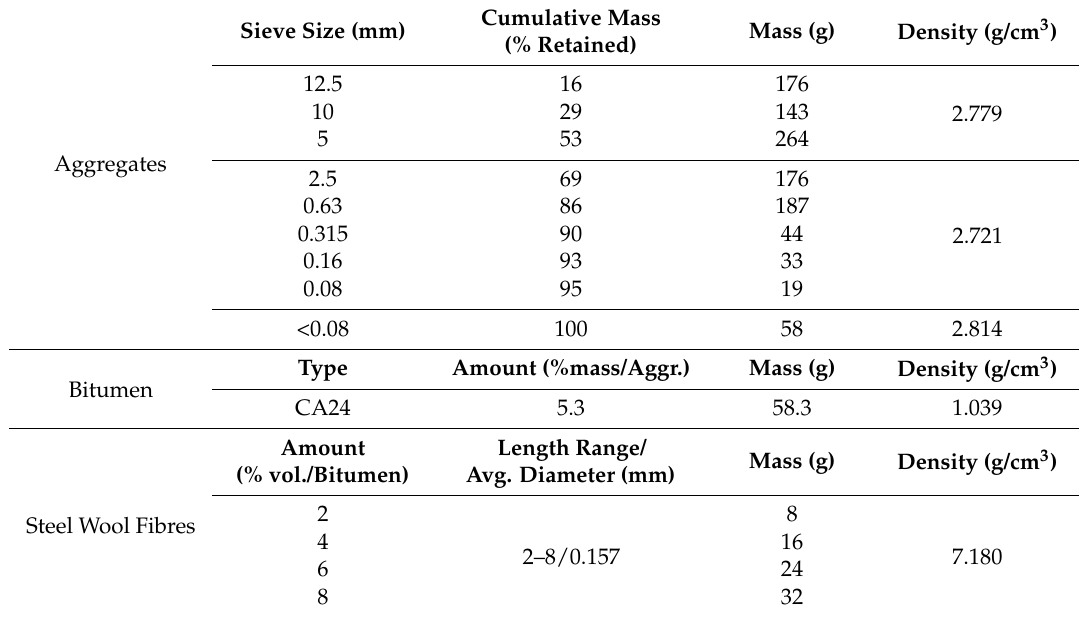
Table 1. Composition of the asphalt mixtures used in the